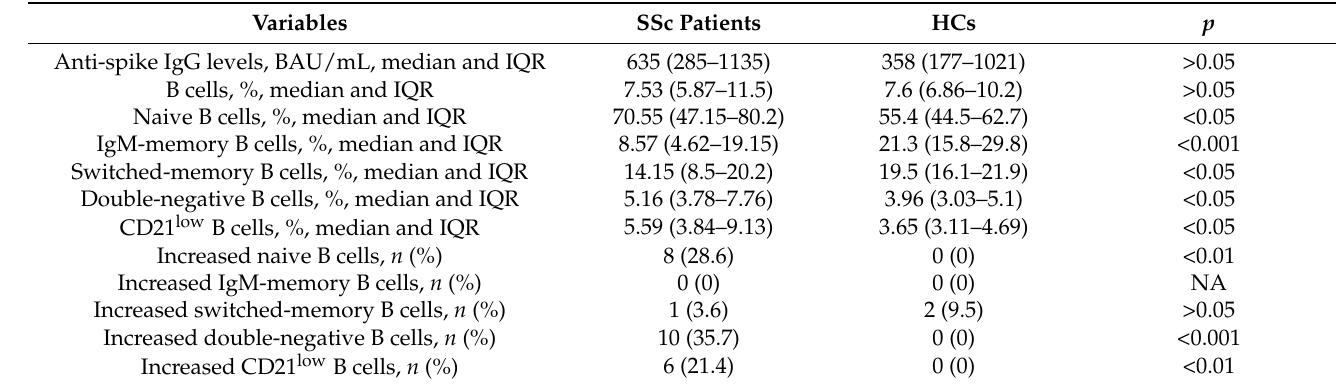
Table 2. B-cell subset distribution at t1 and serum anti-spike IgG levels in 28 systemic sclerosis (SSc) patients and 21 healthy controls (HCs).